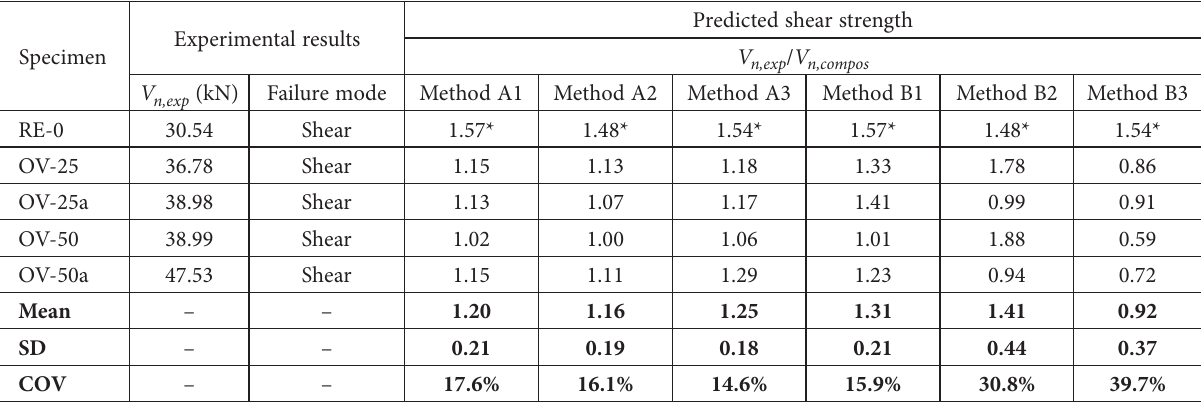
Table 3. Predicted and experimental shear strength results (OV series including RE-0)